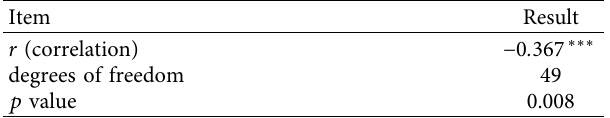
Table 4: The repeated measurement correlation between perceived peer support and willingness of opinion expression.